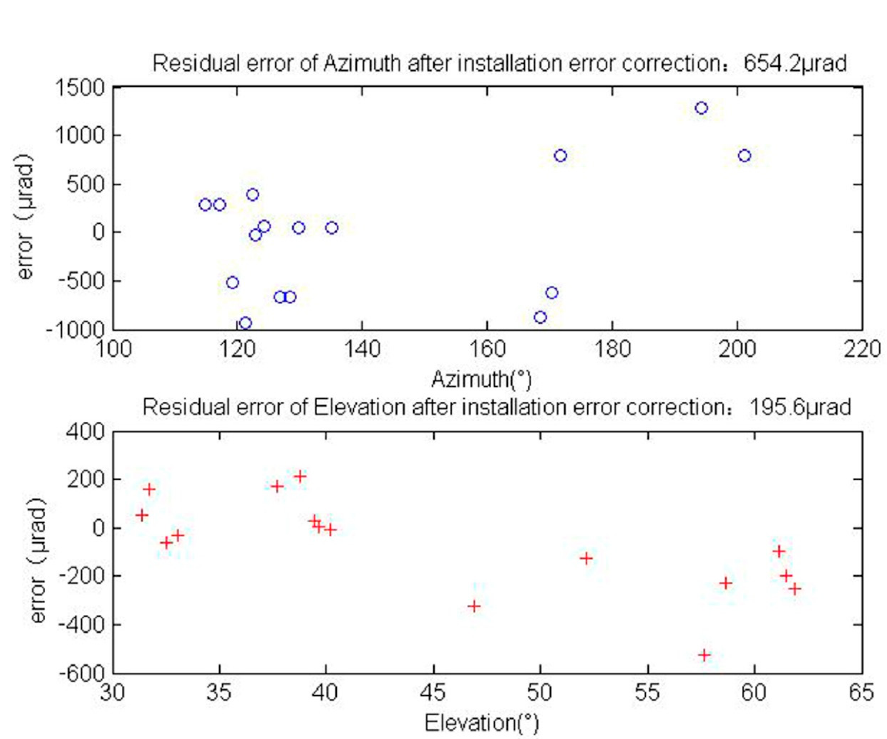
Figure 7. Residual error after installation error calibration. The azimuth residual error is 654.2 µ rad while the elevation residual error is 195.6 µ rad.